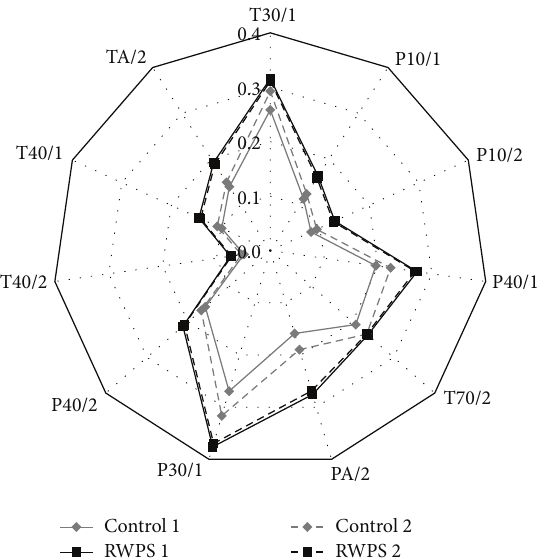
Figure 2: Odor profile of the two different batches of beef patties barbecued without (control) or with red wine pomace seasoning (RPWS), evaluated by the response intensity (( 𝑅 0 − 𝑅 )/ 𝑅 0 ) of 11 sensors from an 𝛼 -FOX electronic